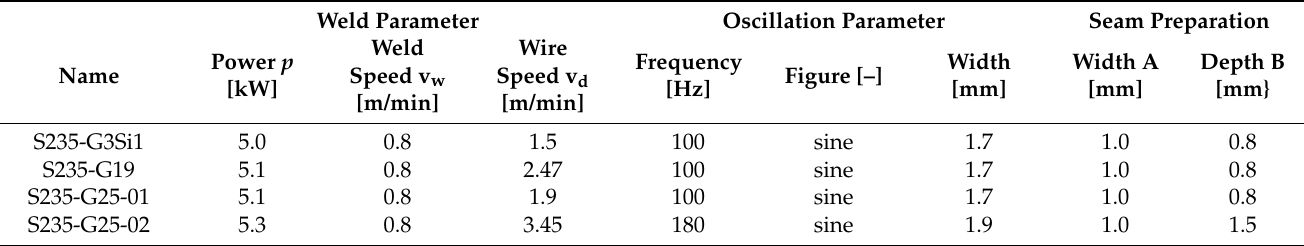
Table 2. Weld and oscillation parameters, as well as seam preparations, for different material combinations. Weld